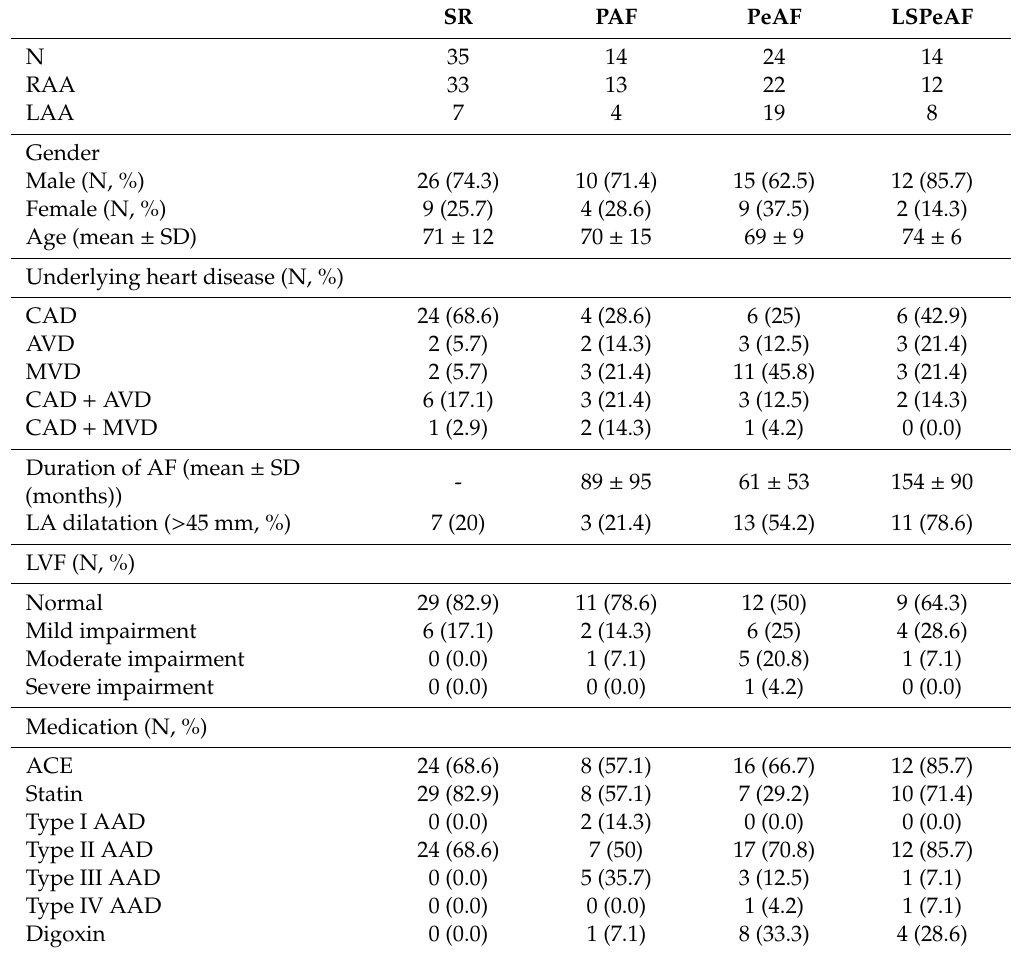
Table 1. Demographic and clinical characteristics of patients with atrial fibrillation (AF) and patients in sinus rhythm (SR), used for ATP measurements and Western blot analysis of atrial appendages. SR PAF